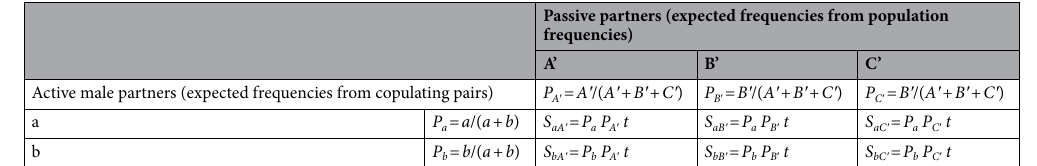
Passive partners (expected frequencies from population frequencies) A’ B’ C’